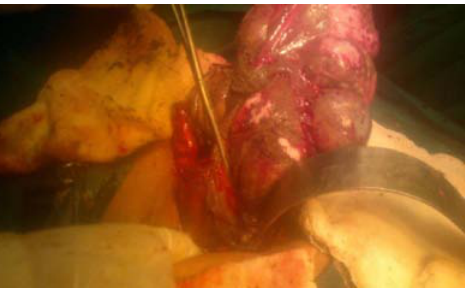
Fig.1. Ultrasound showing Intra uterine fetal death Fig.2. Left dermoid cyst of